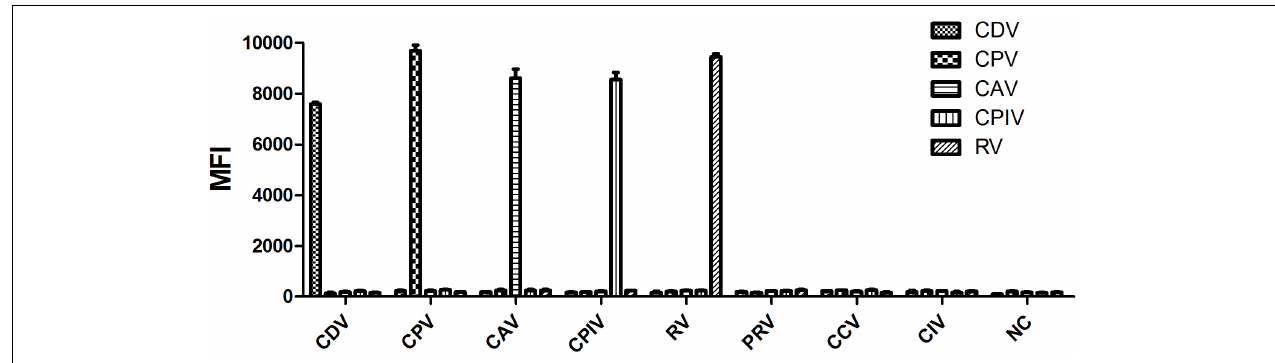
FIGURE 1 | Specificity analysis of the 5-plex Luminex xTAG assay. Each bar represents the average MFI of duplicate samples. CDV, canine distemper virus; CPV, canine parvovirus; CAV, canine adenovirus; CPIV, canine parainfluenza virus; RV, rabies virus; PRV, pseudorabies virus; CCV, canine coronavirus; CIV, canine influenza virus; NC, negative control (water). The result of the 5-plex Luminex xTAG assay showed high specificity.